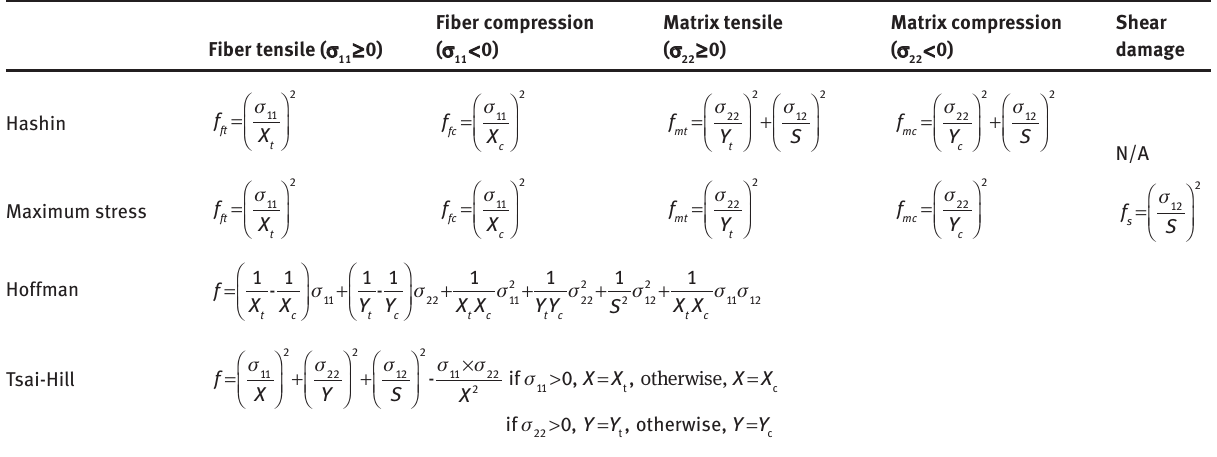
Table 3: Damage initiation for different failure criteria.